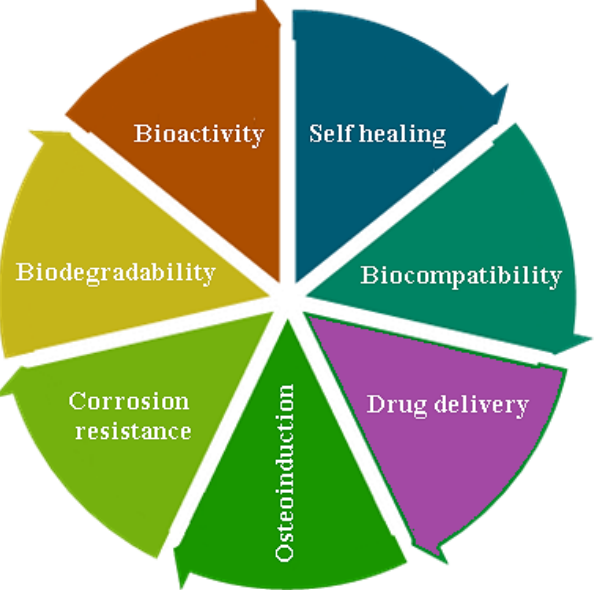
Figure 1. Diverse functionalities of polymer coatings for biodegradable Mg alloys.